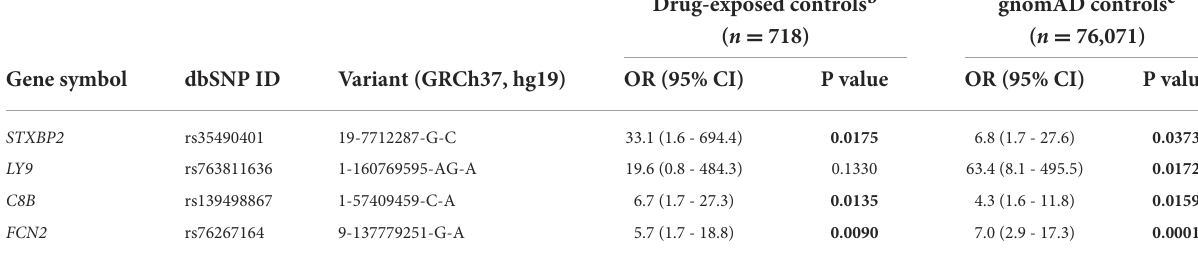
TABLE 2 Association statistics a for PML risk variants: drug-exposed PML cases ( n = 110) vs. drug-exposed controls and gnomAD 3.1 population controls.